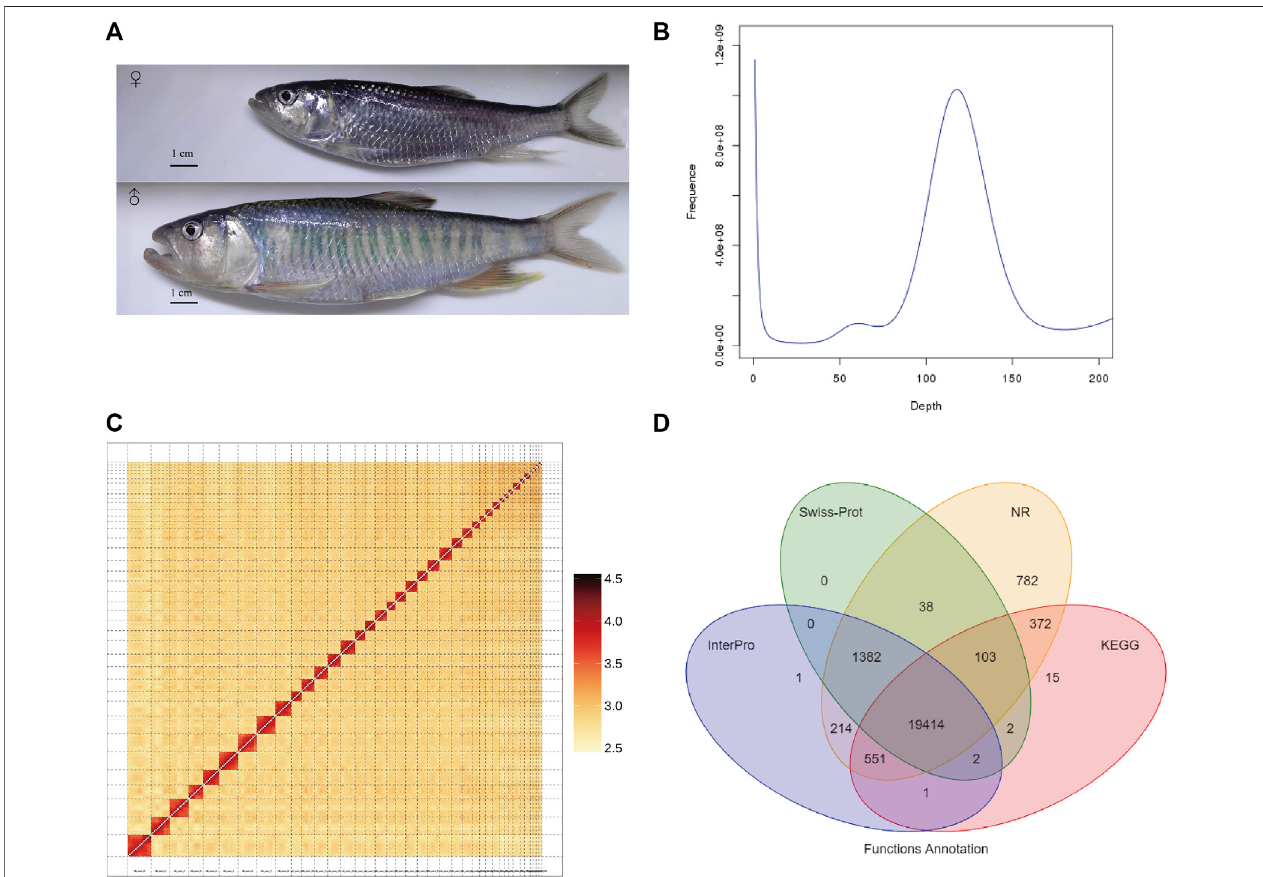
FIGURE 1 | Genome assembly of Opsariichthys bidens . (A) The photo of female and male O. bidens ; The body length and weight of female were 112 mm and 13.3 g, respectively; The body length and weight of male were 171 mm and 56.6 g, respectively. (B) The Kmer (K (cid:1) 17) distribution of O. bidens genome. (C) The Hi-C heatmap used for integrating the scaffolds. (D) The Venn graph of the numbers of annotated genes with different